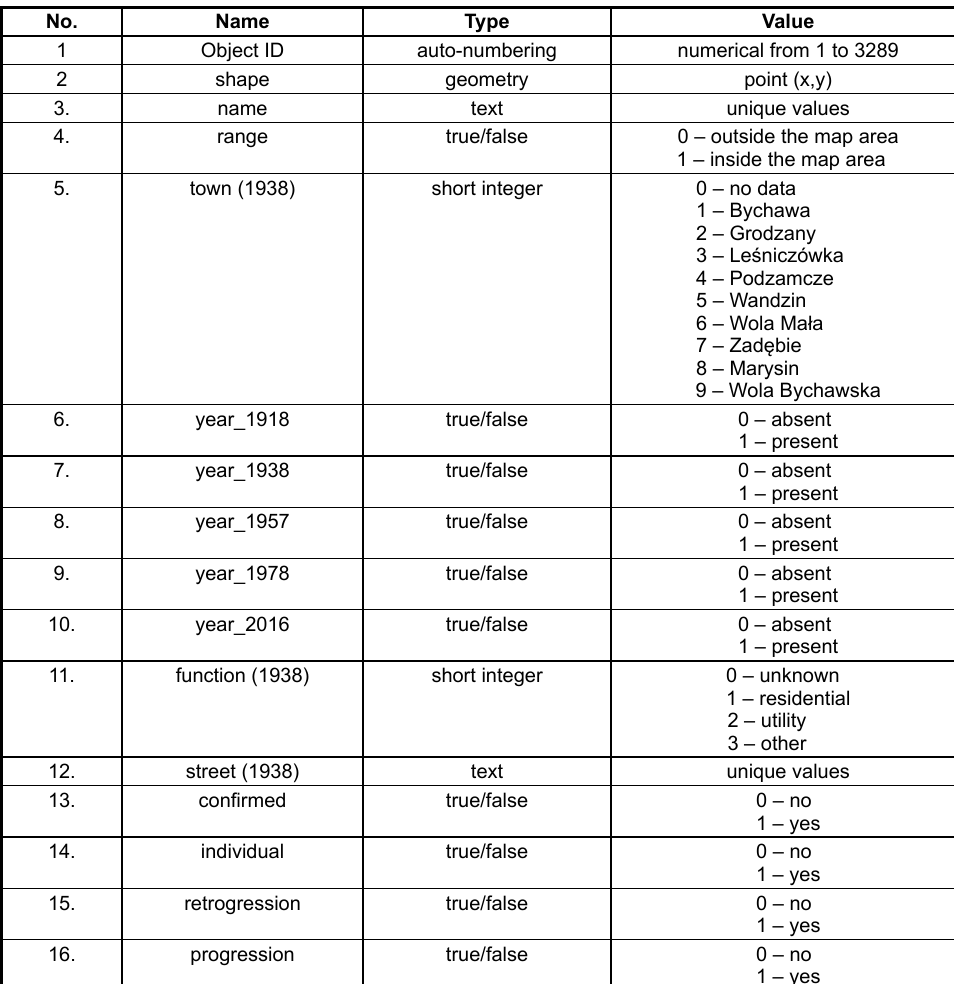
Tab. 1. The GIS layer attribute coding scheme used for the reconstruction of the historical settlement of Bychawa (J. Kuna